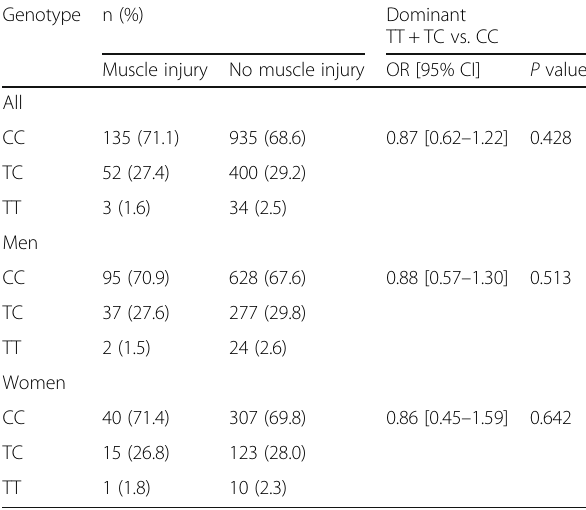
Table 4 Associations of COL5A1 rs12722 genotype with muscle injury Genotype n